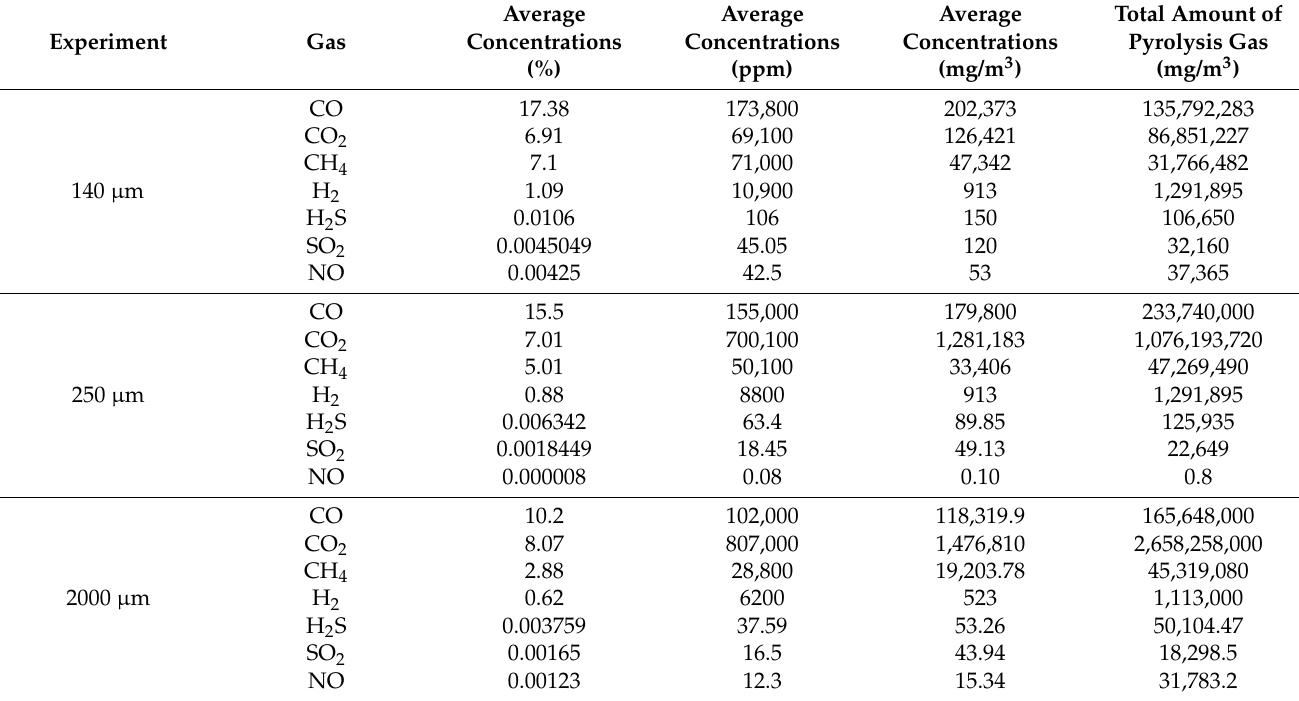
Table 7. The yield of the main gases.